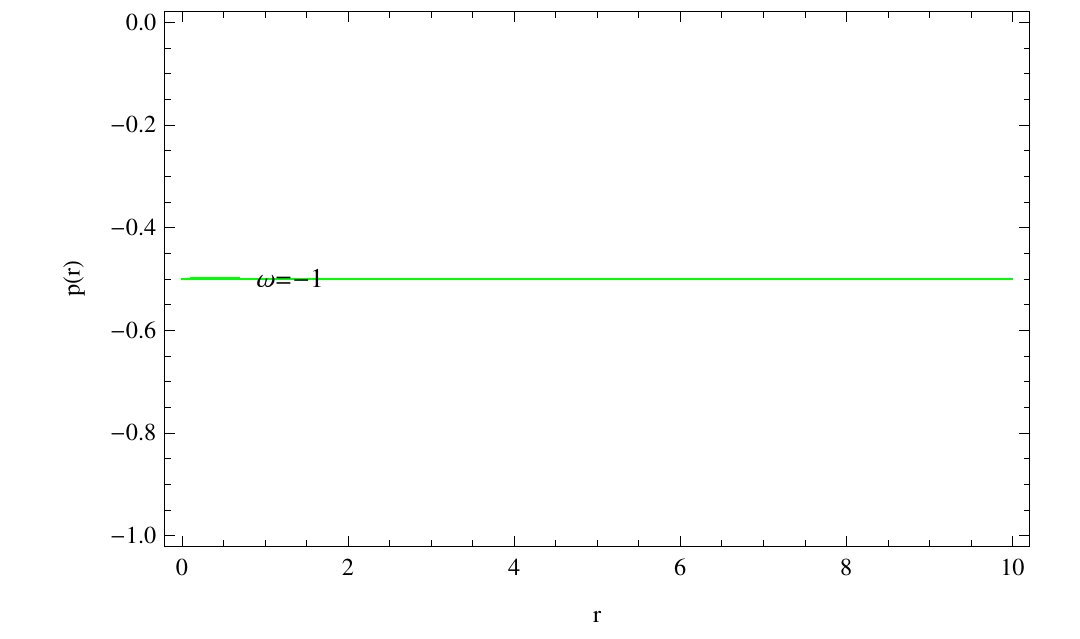
Figure 12. The pressure is plotted against the radial parameter r for the values of constants C 3 = 2, C 4 = 0.001, C 5 = 10.